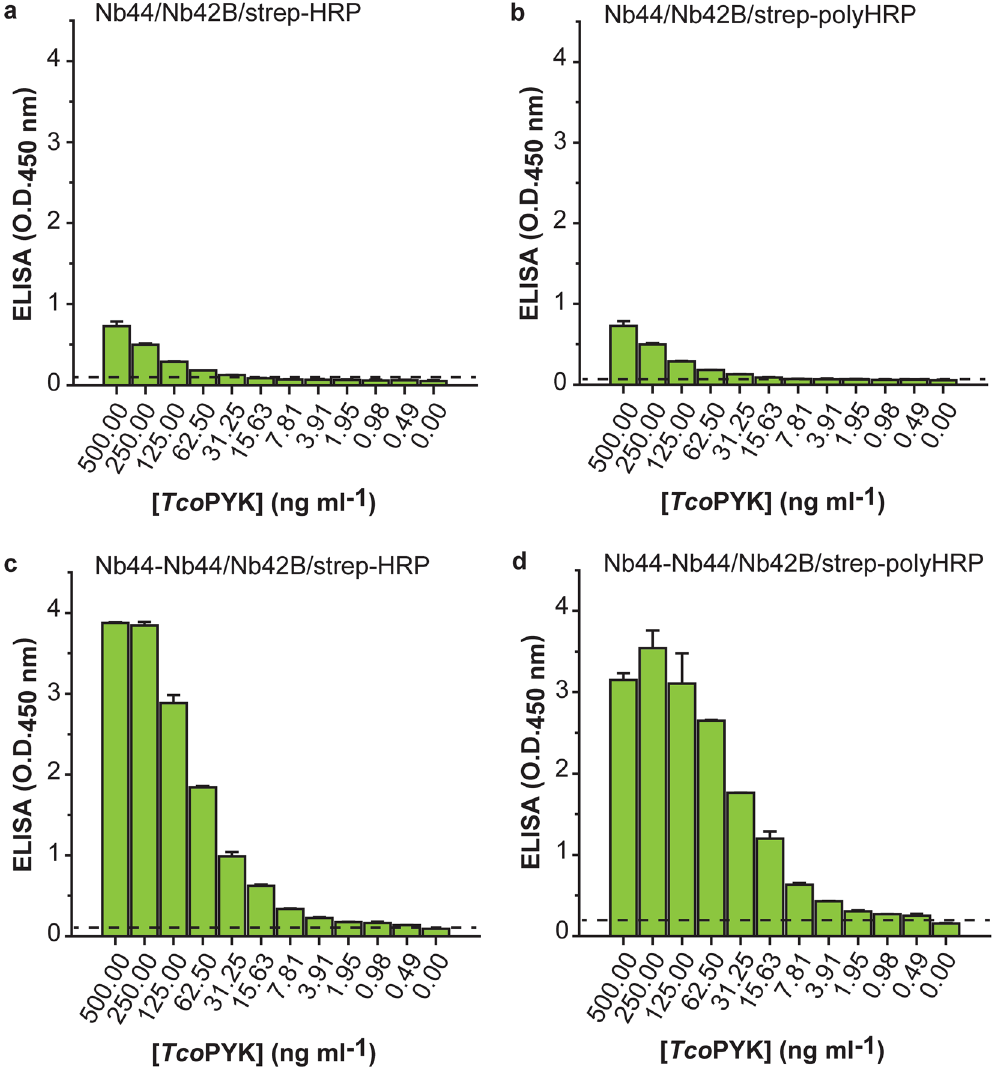
Figure 4. The versatility of Nbs can be exploited to improve the performance of the Nb42/Nb44 ELISA. Nb44/ Nb42 ELISA tested on naive mouse serum spiked with a dilution series of Tco PYK using monovalent Nb44H for capturing, biotinylated Nb42B for detection, and strep-HRP for assay development ( a ) monovalent Nb44H for capturing, biotinylated Nb42B for detection, and strep-polyHRP for assay development ( b ) bivalent Nb44- Nb44H for capturing, biotinylated Nb42B for detection, and strep-HRP for assay development ( c ) and bivalent Nb44-Nb44H for capturing, biotinylated Nb42B for detection, and strep-polyHRP for assay development ( d ). The dashed line displays the ELISA LoD (LoD = mean blank + 3.3 * SD blank ). The concentration of Tco PYK represents the concentration prior to 3-fold dilution into the assay